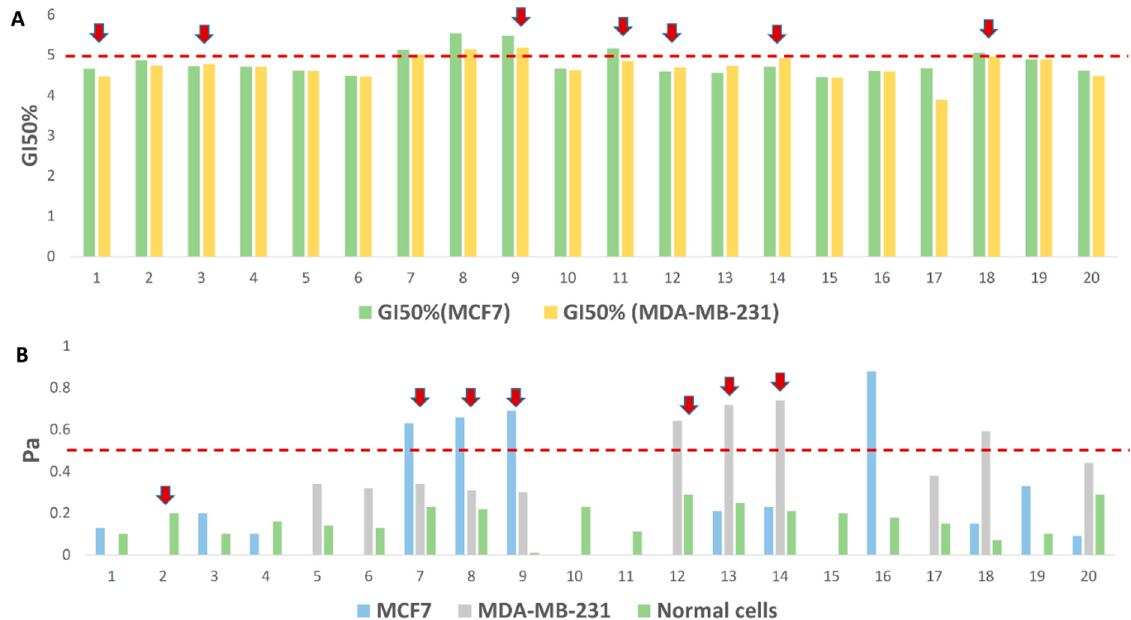
Figure 6. ( A ) The pdCSM-cancer prediction scores of compounds 1 – 20 as anticancer agents. Compounds with GI50% > 5 are probably active against either MCF7 and/or MDA-MA-231 cell lines. Red arrows point to compounds that were predicted to be generally active as anticancer agents. ( B ) The CLC-Pred prediction scores of compounds 1 – 20 as anticancer agents. Pa > 0.5 indicates high probability of activity against either MCF7 and/or MDA-MA-231 cell lines in vitro. Red arrows point to compounds that were predicted to be active against other cancer cell lines in the software’s database.